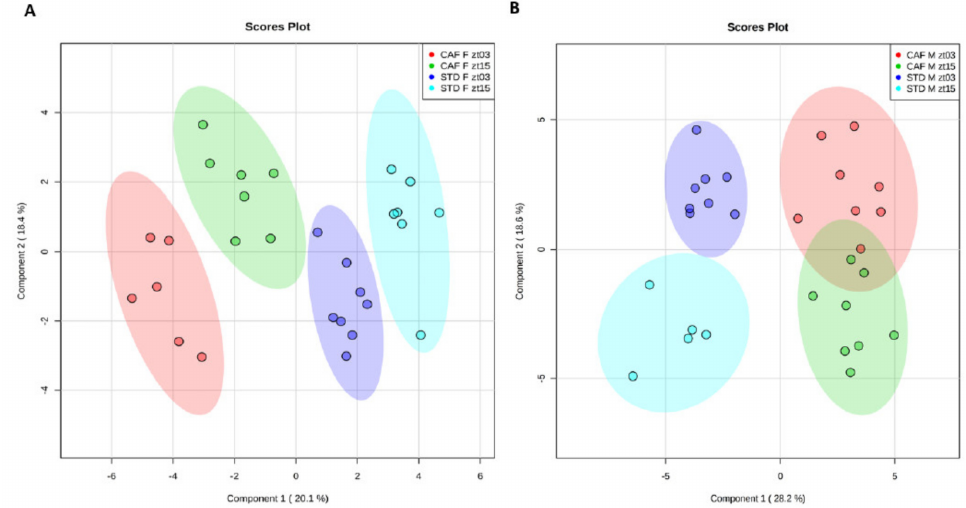
Figure 1. The 45 liver metabolites were used to set up a PLS-DA predictive model. It was done in both, females ( A ) and males ( B ). CAF F ZT3, cafeteria female group at Zeitgeber 3; CAF F ZT15, cafeteria female group at Zeitgeber 15; STD F ZT3, standard female group at Zeitbeger 3; STD F ZT15, standard female group at Zeitbeger 15; CAF M ZT3, cafeteria male group at Zeitgeber 3; CAF M ZT15, cafeteria male group at Zeitgeber 15; STD M ZT3, standard male group at Zeitbeger 3; STD M ZT15, standard male group at Zeitbeger